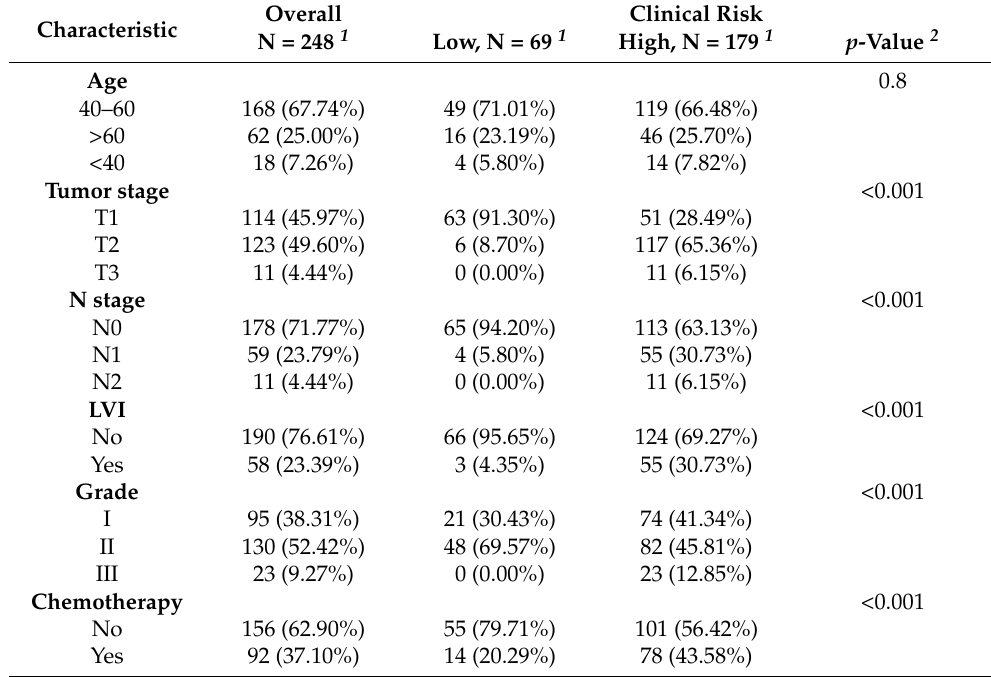
Table 1. Basic clinical characteristics of enrolled luminal-like breast cancer